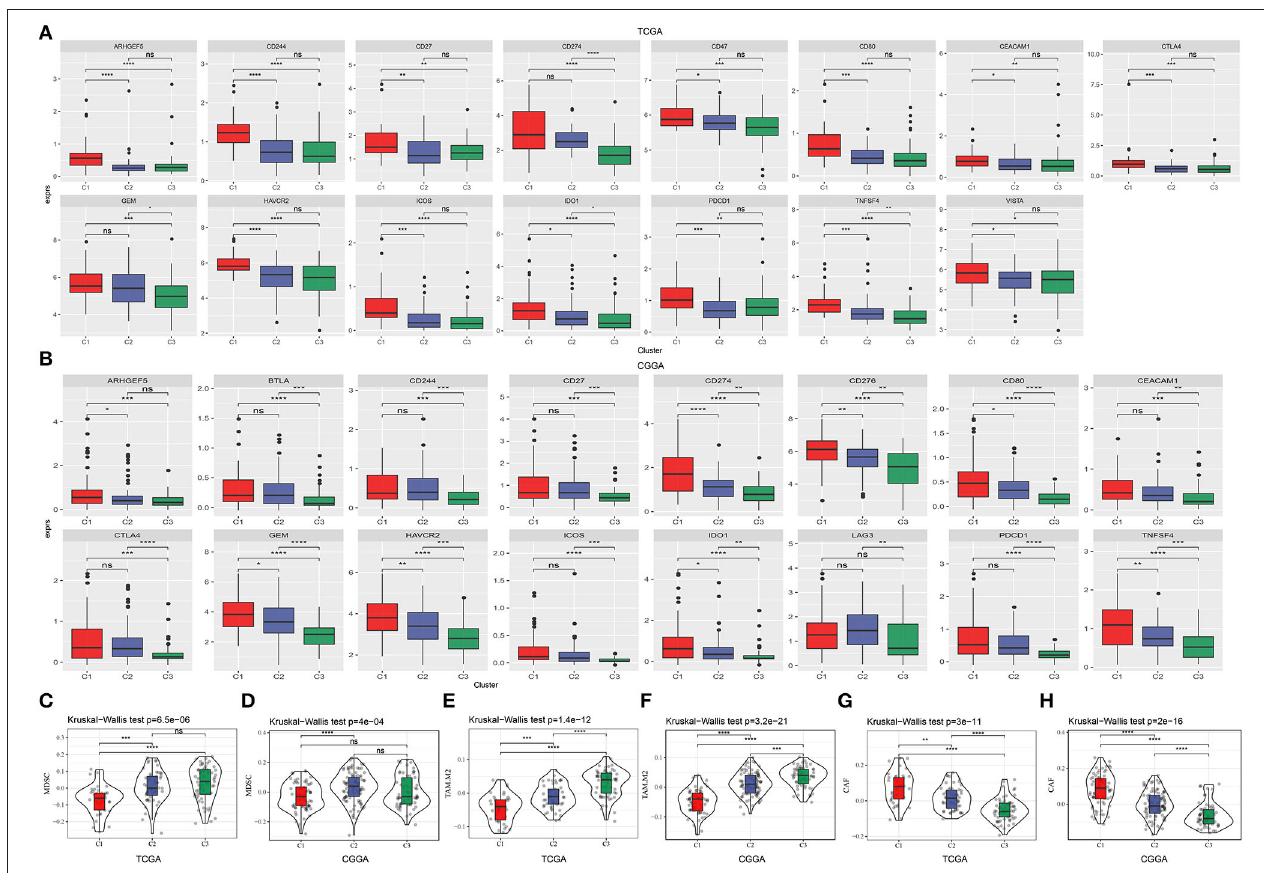
FIGURE 5 | Expression of immune checkpoints and the proportion of critical immune cells in three subtypes. (A,B) Immune checkpoints that were differentially expressed among three subtypes in TCGA-GBM and CGGA-GBM datasets. The vertical axis indicates log (TPM + 1) expression value. ANOVA was conducted. (C–H) Estimated proportion of myeloid-derived suppressor cells (MDSCs), M2 tumor-associated macrophages (TAMs) and cancer-associated fibroblasts (CAFs) in TCGA-GBM and CGGA-GBM datasets. The Kruskal–Wallis test was conducted. ns, no significance. * p < 0.05, ** p < 0.01, *** p < 0.001, **** p <